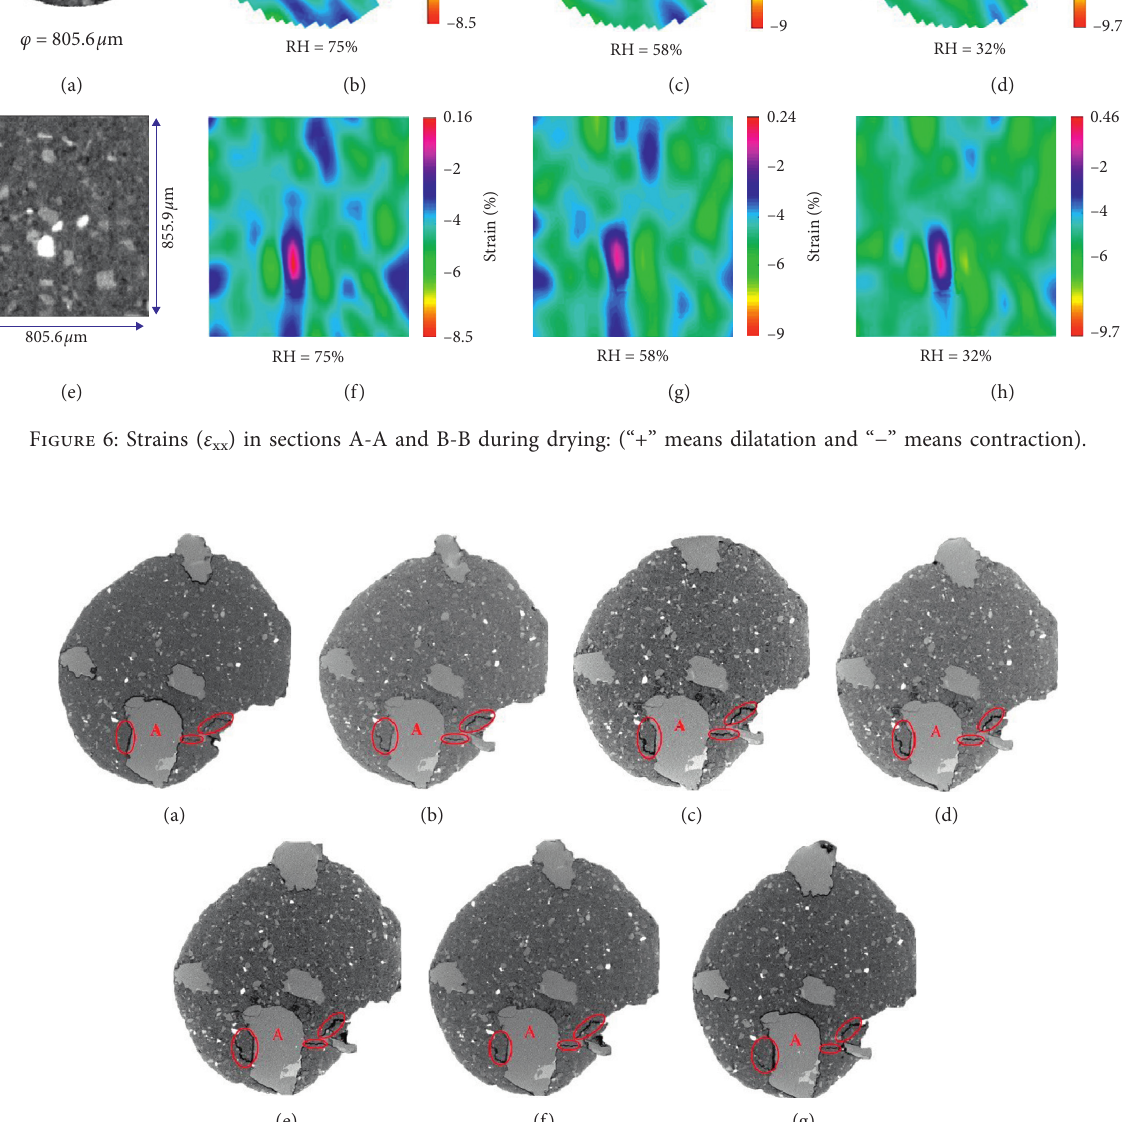
Figure 7: CTimages of the GMZ bentonite during drying (from Figures 6(a) to 6(d)) and wetting (from Figures 6(d) to 6(g)): (a) RH � 98%, (b) RH � 75%, (c) RH � 58%, (d) RH � 32%, (e) RH � 58%, (f) RH � 75%, and (g) RH �